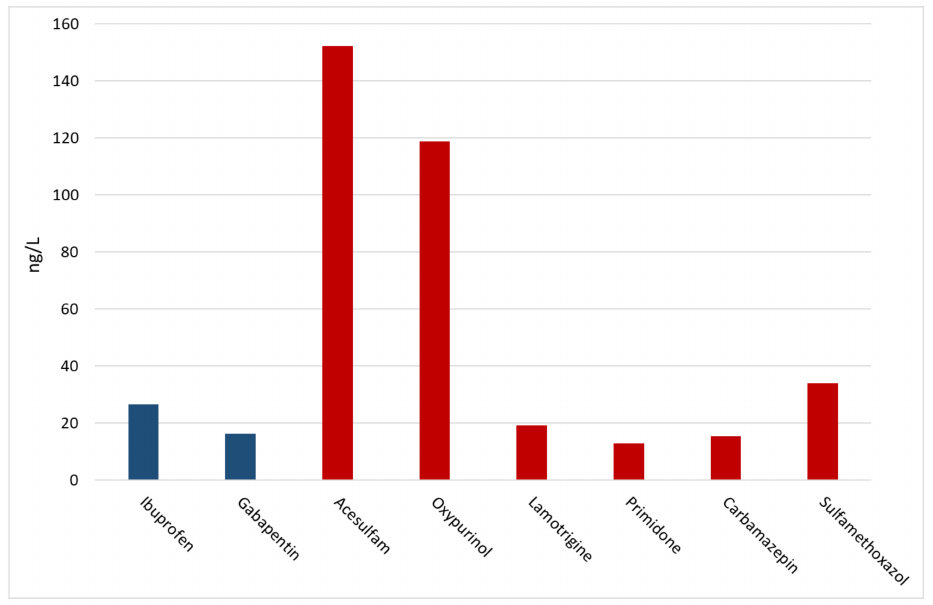
Figure 9. Long-term average values of PPCPs detected in water after artificial recharge (blue are mean values of random occurrences, red are mean values of systematically occurring substances). Table 1. Contents of PPCP substances in monitoring wells SO 1032, HS1, HS2, HS3, HS4 and HS5 of